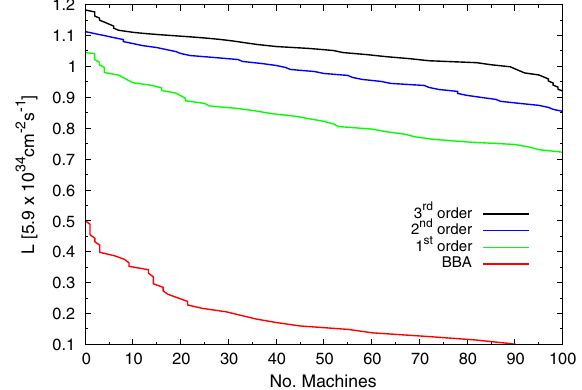
FIG. 4. Tuning results for single beam case study. Red curve shows the accumulated luminosity histogram after BBA. Green, blue, and black curves represent the maximum luminosity obtained by scanning 1st, 2nd, and 3rd order knobs, respectively.